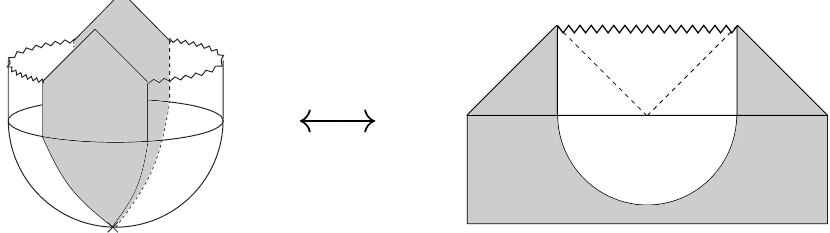
Figure 14. On the left we have reproduced figure 9, corresponding to the Euclidean preparation of a 4 π universe with frozen regions denoted in gray. On the right we have the Euclidean preparation of the thermofield double in AdS coupled to frozen flat-space “wing” regions. The solid black line in the middle is the time-reflection symmetric point where the Euclidean manifold is pasted to the Lorentzian manifold. These two situations are